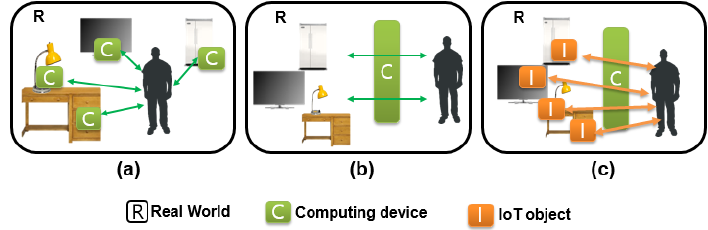
Figure 4. System combining augmented reality (AR) with IoT with a comparison of Human Computer Interaction (HCI) styles such as ubiquitous computers and augmented interactions [31]: ( a ) ubiquitous computer, ( b ) augmented interaction, ( c ) proposed AR mixed with IoT. Sensors 2019 , 19 , 4330